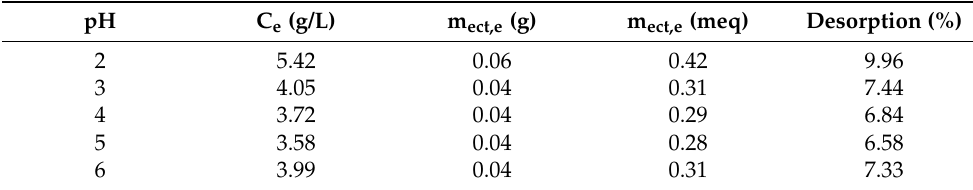
Table 6. Effect of pH on ectoine desorption from saturated Dowex ® HCR-S resins. pH C e